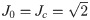
DMFT for the inhibitory rate model with threshold-linear transfer function.A: The PAC amplitude, σ
0 − σ
∞, is plotted against J
0. At fixed point σ
0 − σ
∞ = 0 (blue). When J0=Jc=2 (black dot, BP) a bifurcation occurs and the chaotic state appears. For J
0 > J
c, the fixed point is unstable (dashed blue) and the network settles in the chaotic state (σ
0 − σ
∞ > 0, black). Red: Perturbative solution in the limit J
0 → J
c (see S4 Text). Inset: σ0−σ∞ plotted against δ = J
0 − J
c showing that σ
0 − σ
∞ vanishes quadratically when δ → 0+. Black: Full numerical solution of the DMFT equations. Red: Perturbative solution at the leading order, O(δ). B: (σ − σ
∞)/δ
2 is plotted for different values of δ > 0 to show the convergence to the asymptotic function derived perturbatively in S4 Text. Inset: The function (σ(τ) − σ
∞)/δ
2 (black) can be well fitted to A/cosh(x/x
dec) (red dots, A = 12.11, x
dec = 2.84). C: Decorrelation time, τ
dec vs. PAC amplitude (blue). The function σ(τ) − σ
∞ was obtained by integrating numerically Eq (29) and τ
dec was estimated by fitting this function to A/cosh(τ/τ
dec). Red: In the whole range of J
0 considered (J
0 ∈ [1.4, 1.9] the relation between τ
dec and σ
0 − σ
∞ can be well approximated by y=5.29/x4. Inset: The PAC computed by solving the DMFT equations for J
0 = 1.81 (blue dots) and the fit to 0.93/cosh(τ/4.6). D: The PAC for J
0 = 2 and K = 1200. Blue: Numerical integration of Eq (29). Red: Numerical simulations for N = 256,000.